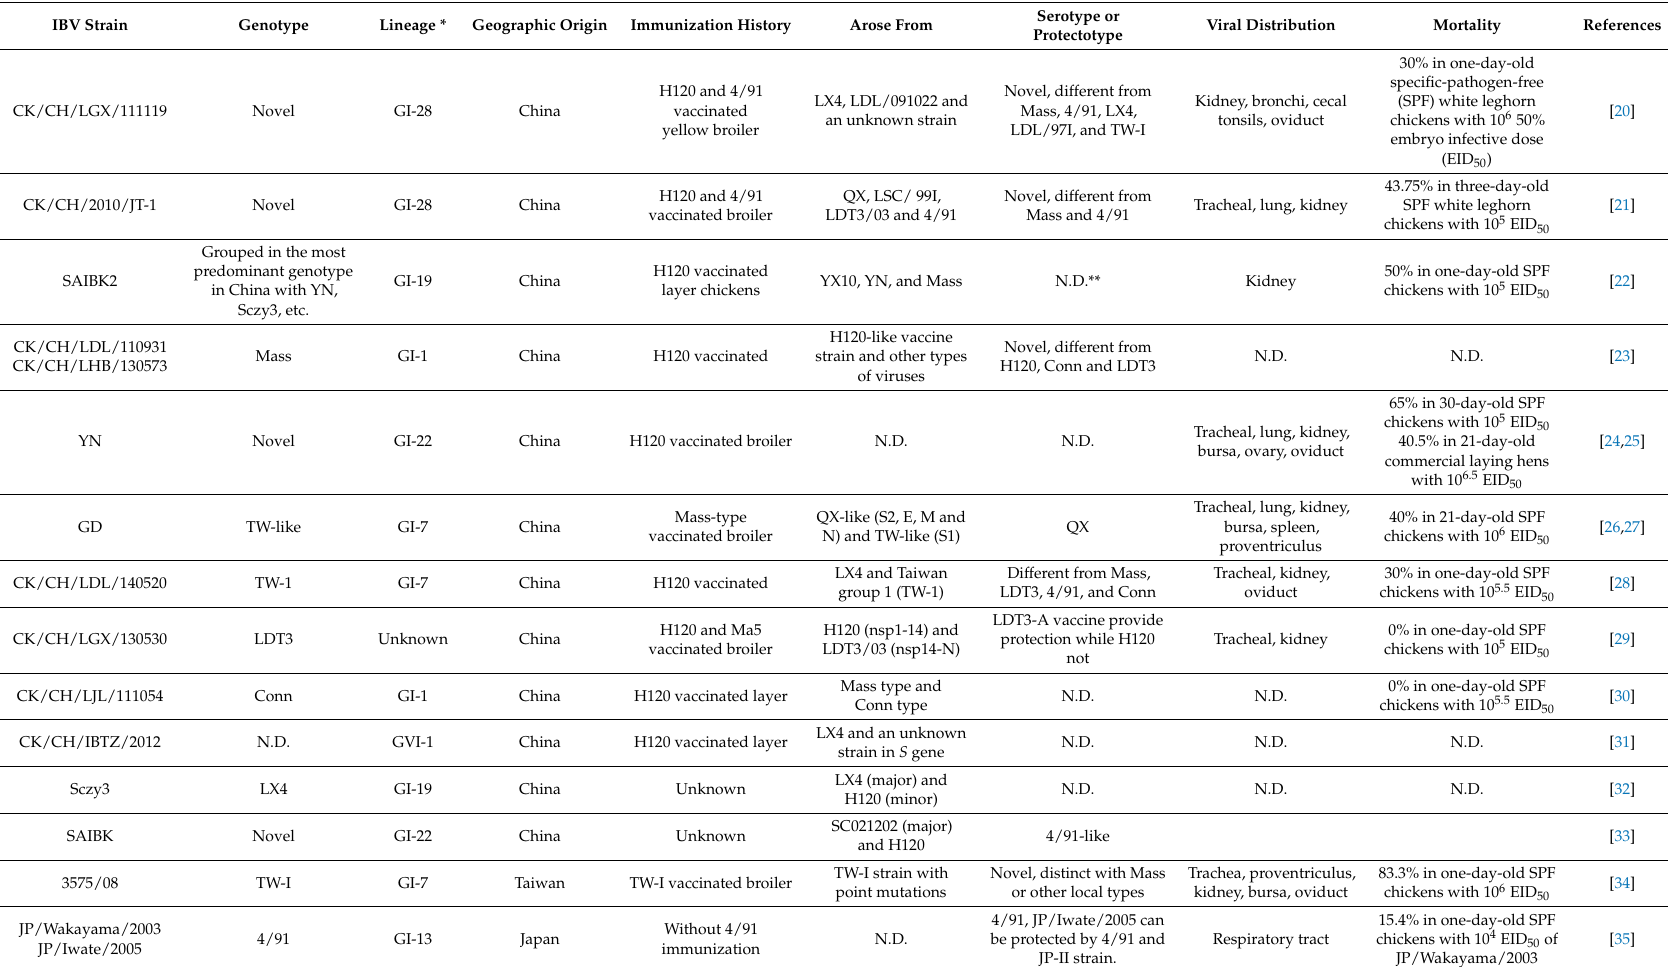
Table 1. Genotypes, serotypes and pathotypes of the described infectious bronchitis virus (IBV)